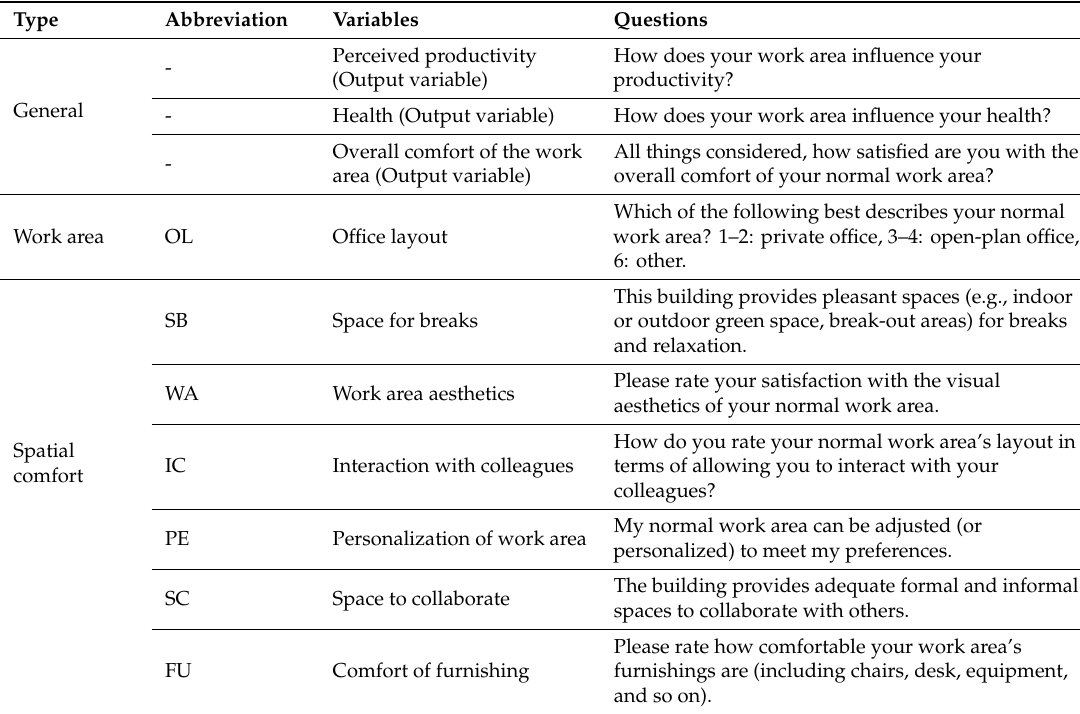
Table 1. BOSSA (Building Occupant Survey System Australia) Time-Lapse post-occupancy evaluation (POE) questionnaire items used as input and output (first 3)